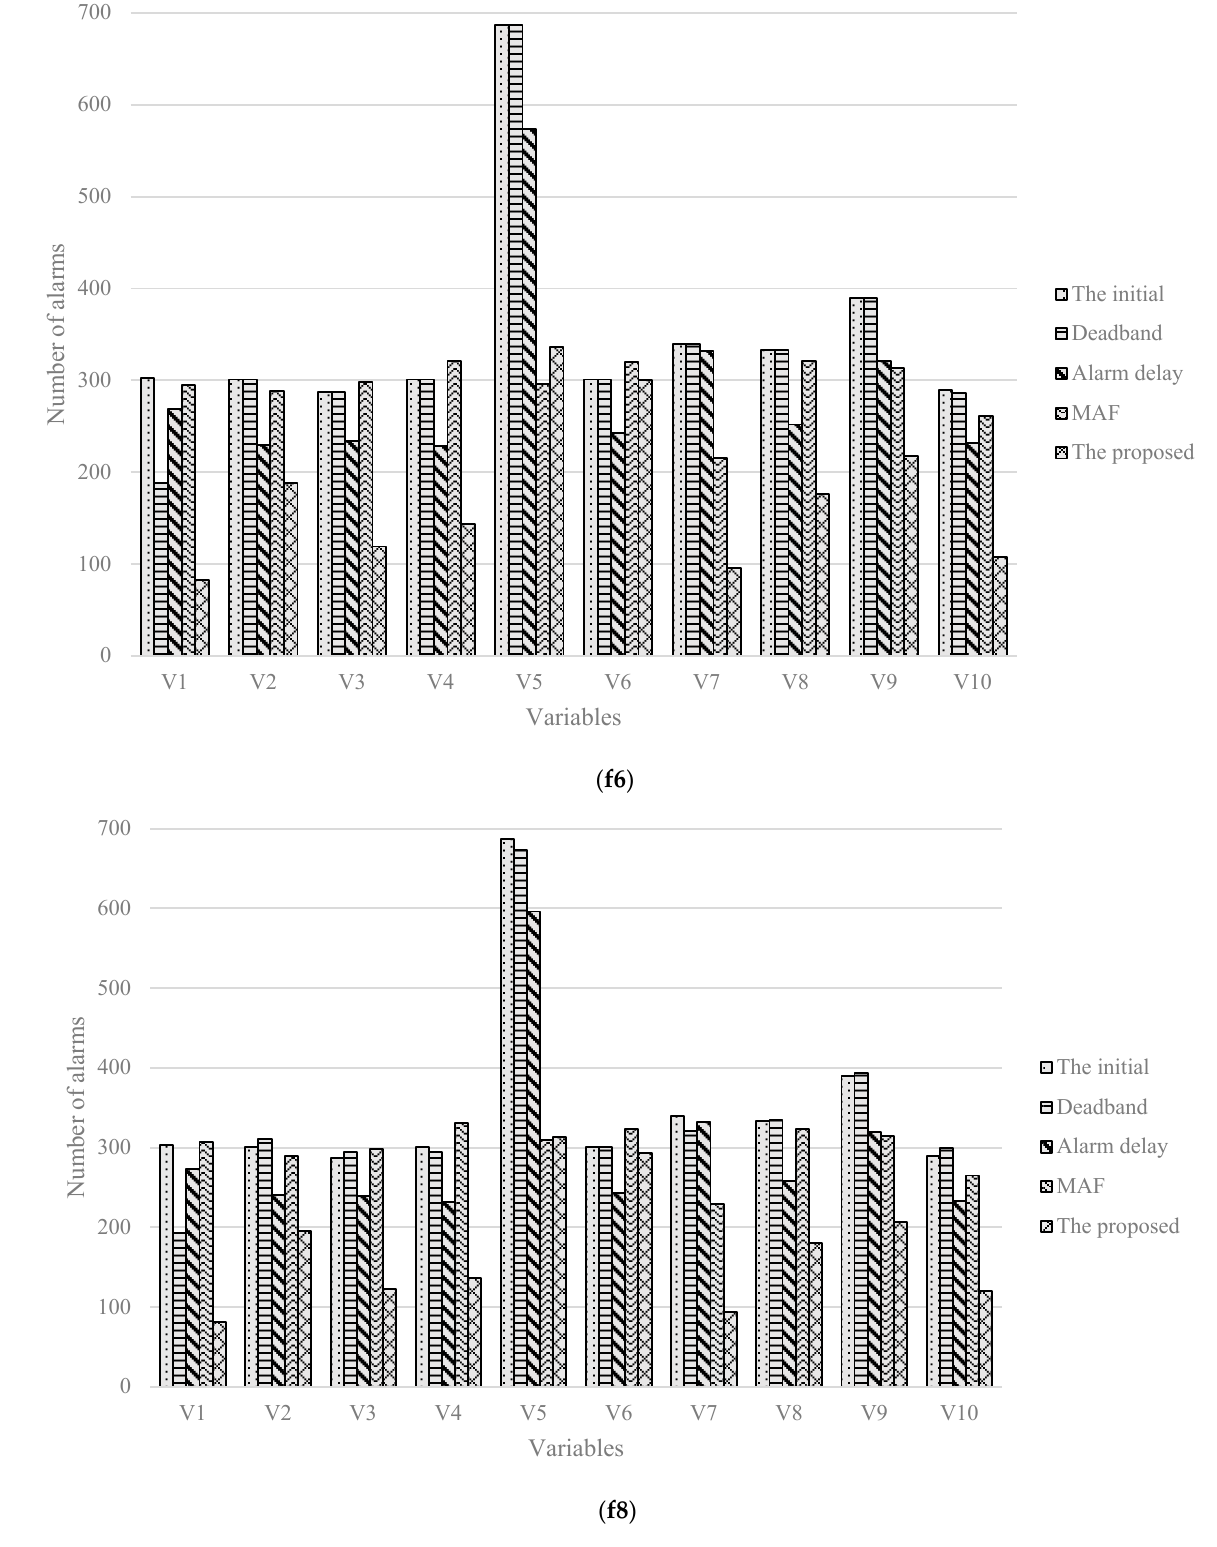
Figure 8. Histograms of number of alarms in five cases with two failures ( f6 , f8 ).